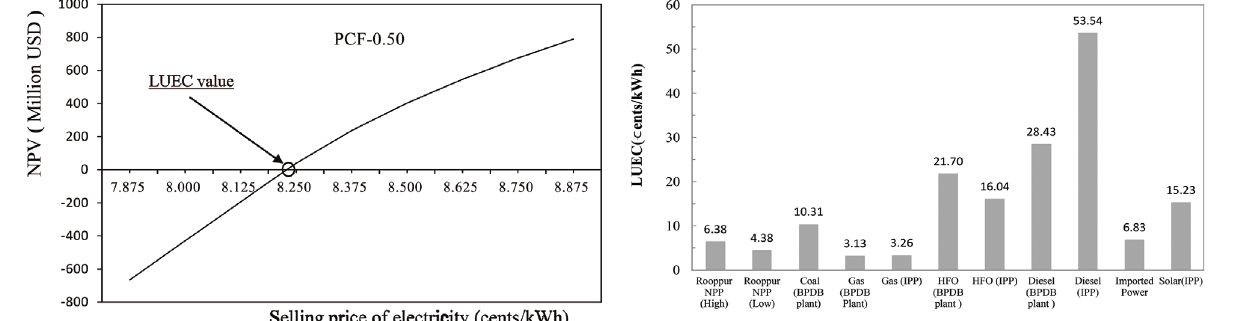
Figure 7. Variation of NPV with selling price of electricity (cents/kWh) considering high plant O&M costs-14.5$/MWh and fuel costs-11.2$/MWh, discount rate-10% and PCF-50%.